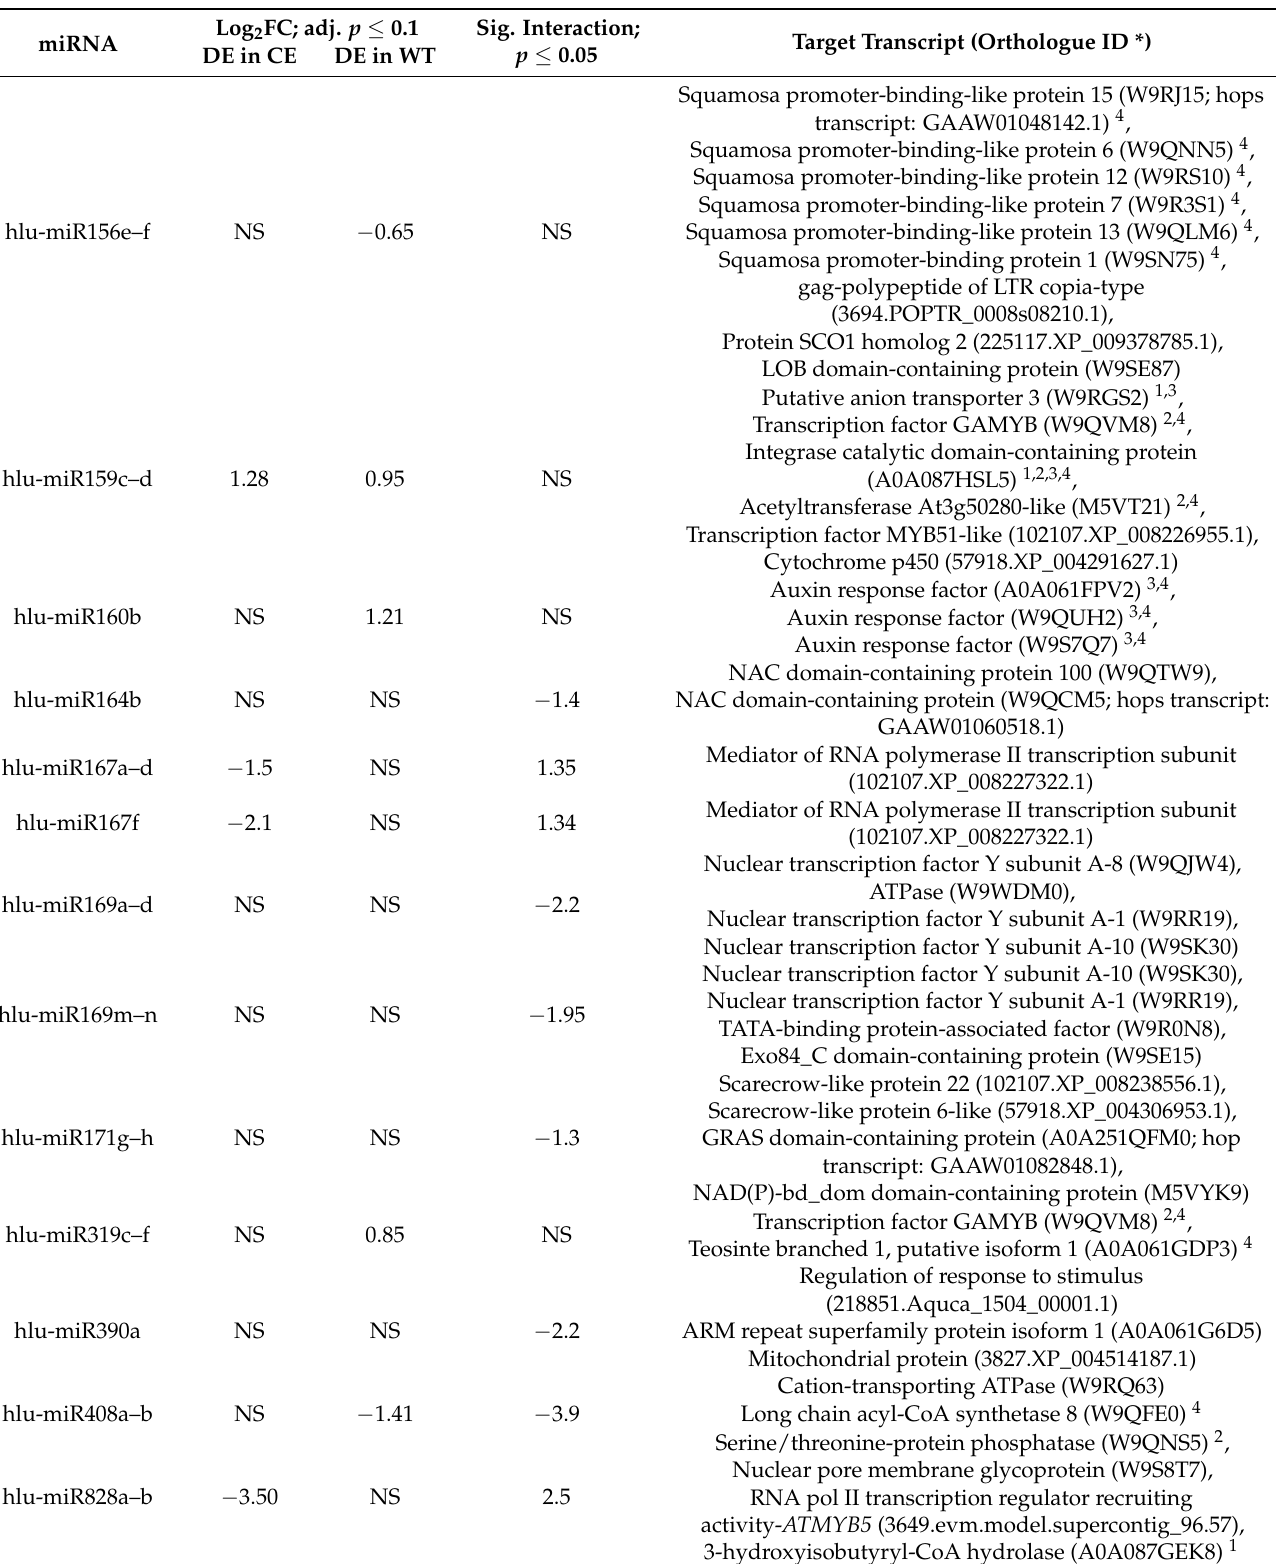
Table 2. Differentially expressed miRNAs in response to inoculation with V. nonalfalfae and their target transcripts in hops.